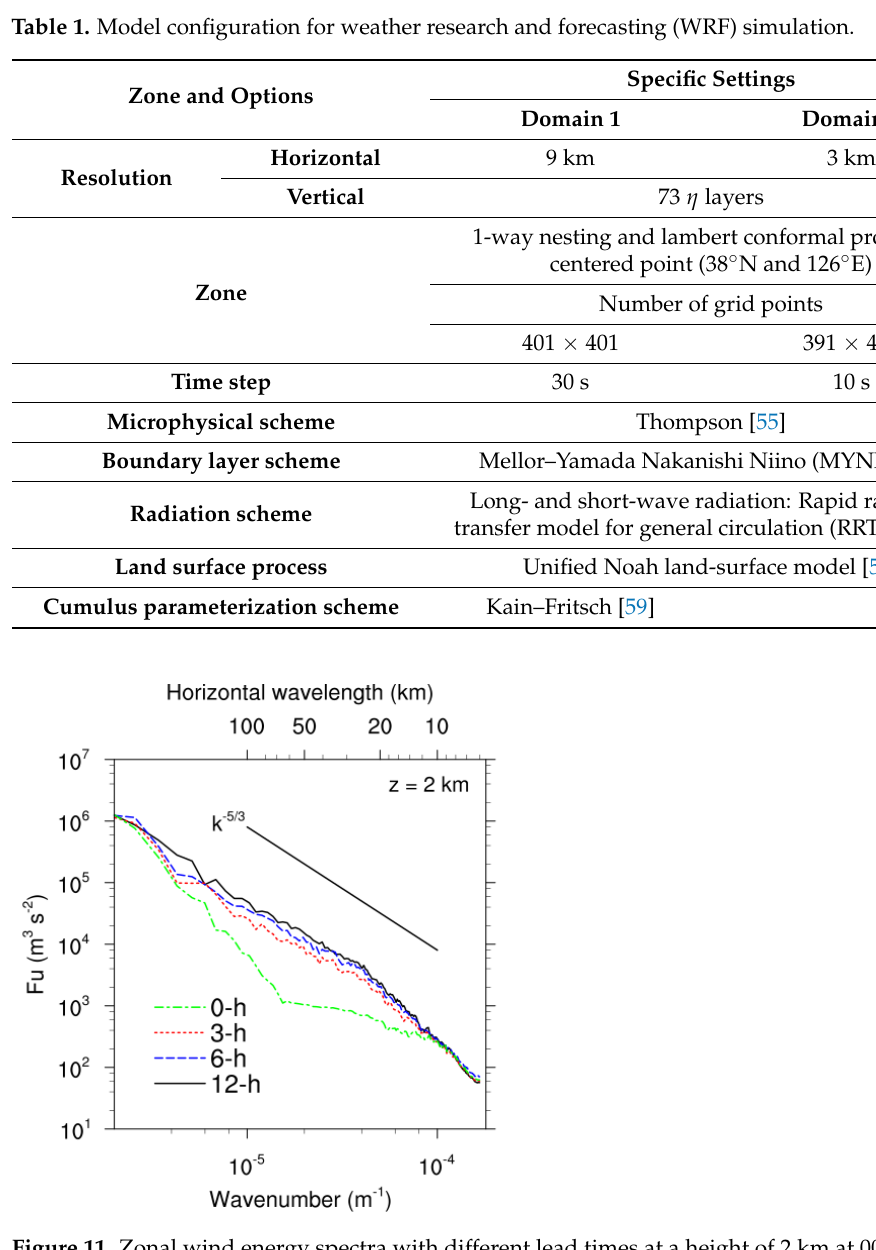
Figure 11. Zonal wind energy spectra with different lead times at a height of 2 km at 00:00 UTC 28 October 2018. Each spectrum corresponding to 0, 3, 6, and 12 h forecasts was calculated over domain 2 in the zonal direction and was averaged in the meridional